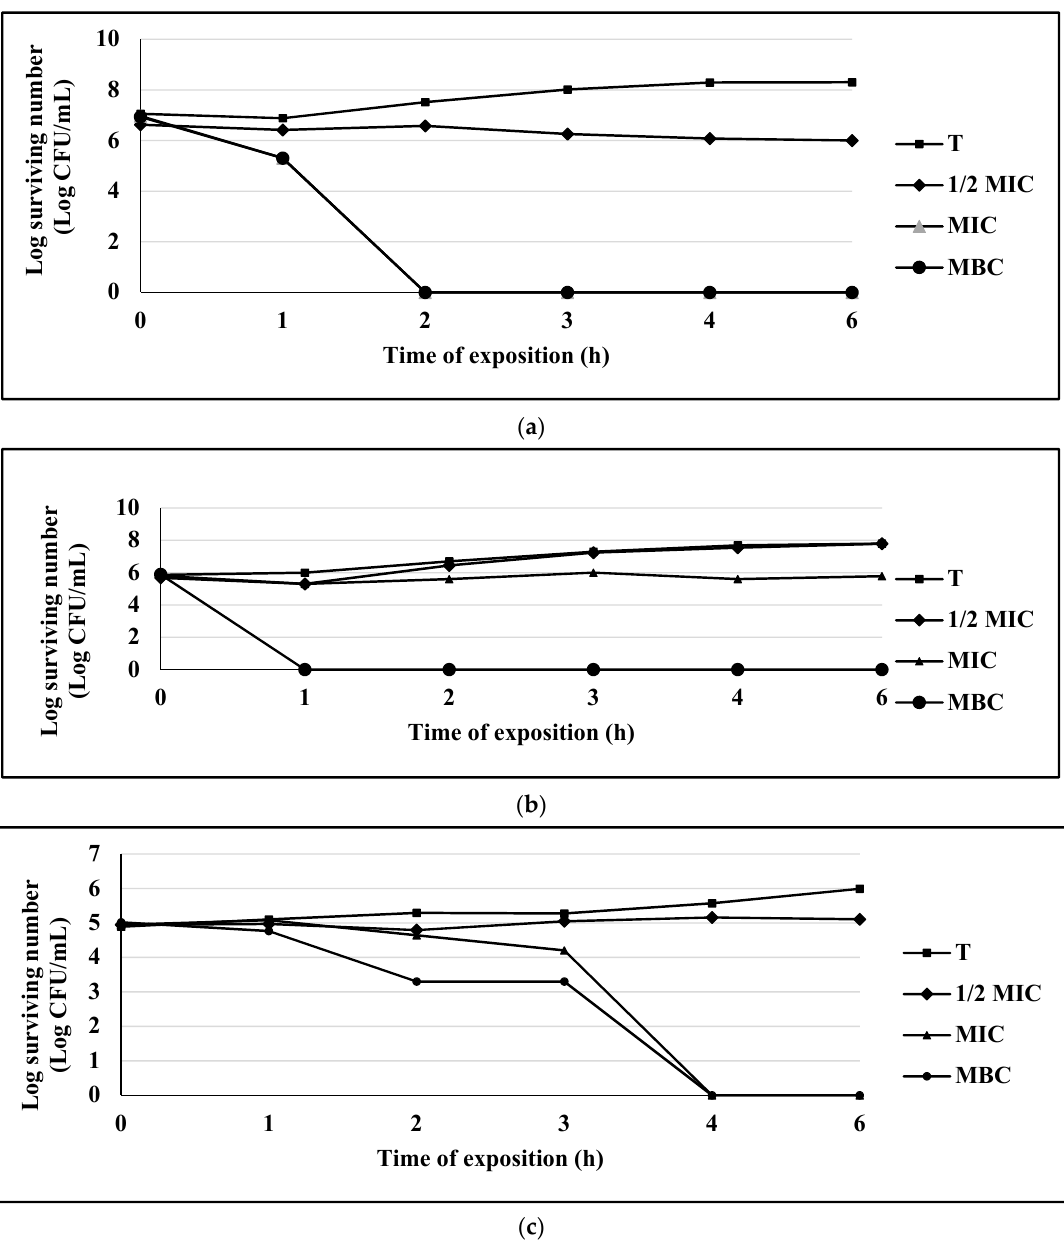
Figure 1. ( a ) Survival curve of E. coli exposed to eugenol. Data are represented as the mean ± S.E. ( n = 3). The concentrations used were: 0.125 mg/mL (½ MIC), 0.25 mg/mL (MIC), and 0.5 mg/mL (MBC); the control group (T) only contains the bacterial culture. ( b ) Survival curve of S. aureus 75MR exposed to eugenol. Data are represented as the mean ± S.E. ( n = 3). The concentrations used were: 0.25 mg/mL (½ MIC), 0.5 mg/mL (MIC), and 1.0 mg/mL (MBC); the control group (T) only contains the bacterial culture. ( c ) Survival curve of C. albicans CUSI exposed to eugenol. Data are represented as the mean ± S.E. ( n = 3). The concentrations used were: 0.125 mg/mL (½ MIC), 0.25 mg/mL (MIC), and 0.5 mg/mL (MBC); the control group (T) only contains the bacterial culture.